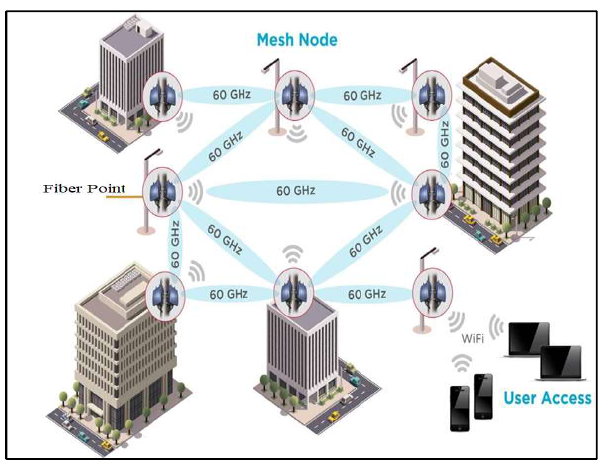
Figure 2. Example of wireless backhaul network.